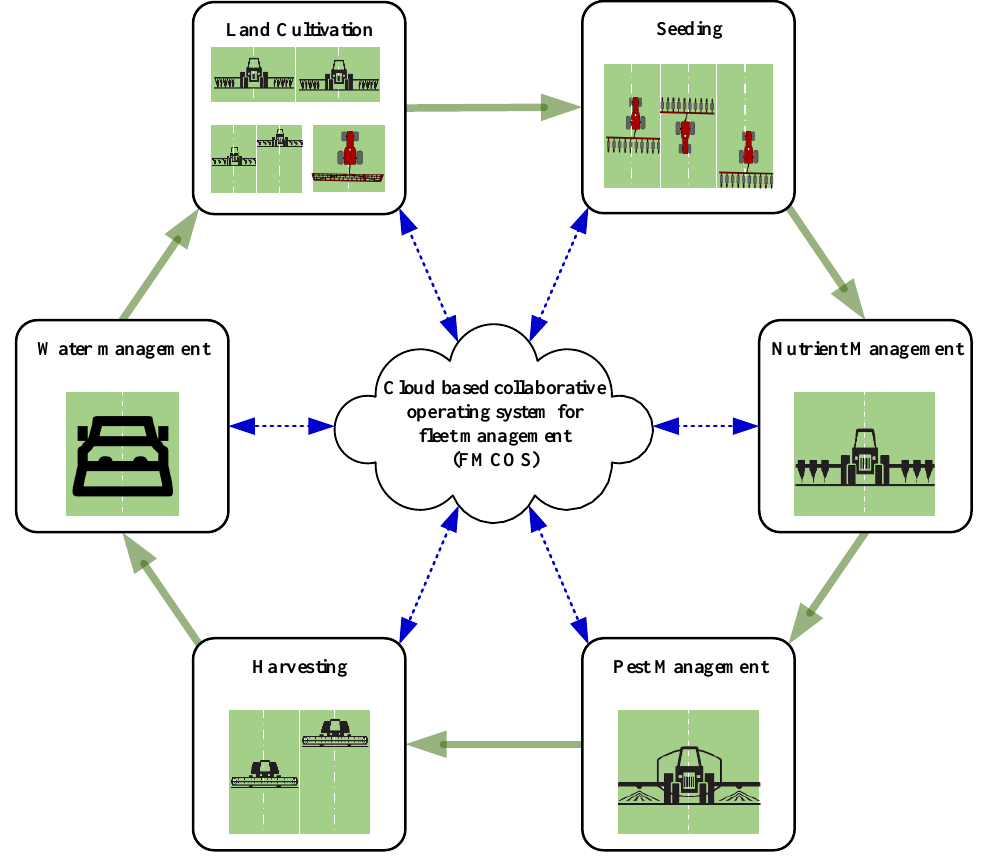
Figure 1. Collaborative application for the production cycle of field crop planting and management.